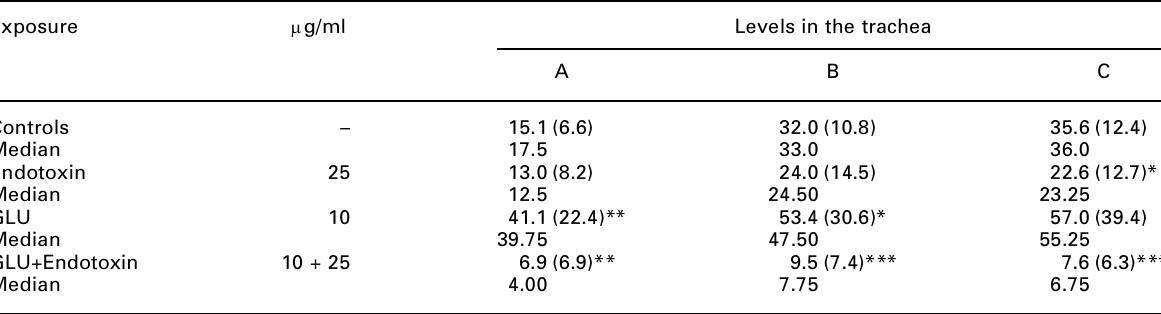
Table 1. Eosinophilic leukocytes in tracheal epithelium (cells/field at 40 ´ magnification) of guinea pigs exposed to endotoxin, (1 ® 3)- b -D-glucan (GLU) or endotoxin + GLU Exposure m g/ml Levels in the trachea